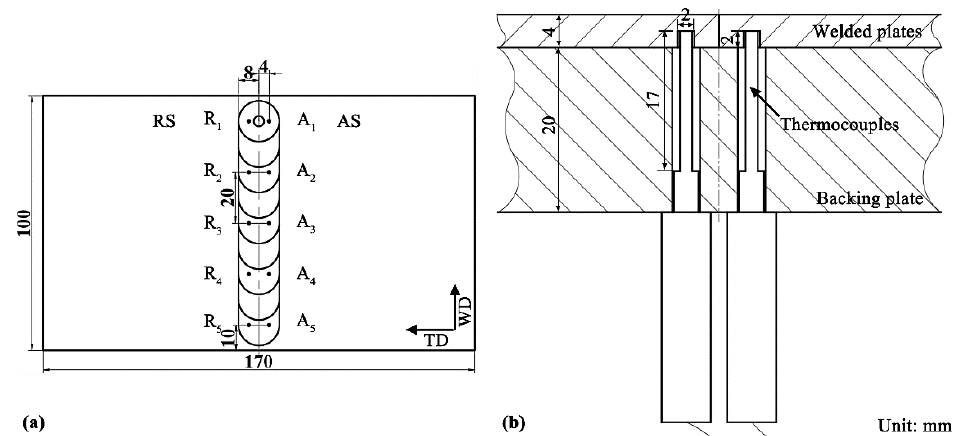
Figure 2. The schema of the thermocouples fixed in the welded plates: ( a ) The distribution of thermocouples along the welding direction and the transverse direction (unit: mm). In this map, the black points indicate the K-type thermocouples (total of 5 thermocouples at each side). The black points marked as A 1 to A 5 are the feature points distributed at the advancing side (AS), and R 1 to R 5 are the feature points at the retreating side (RS). The welding direction is marked as WD and the direction perpendicular to it on the welded plates is marked as TD. ( b ) is the magnified schema for the fixing directions of the thermocouples and the depth of the hole.